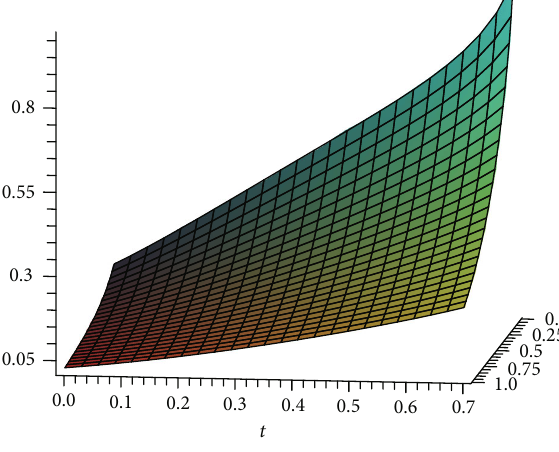
ffiffiffiffiffiffiffiffiffiffi p 1 + x , A ð t Þ = ln ð 1 : 3 + t Þ .